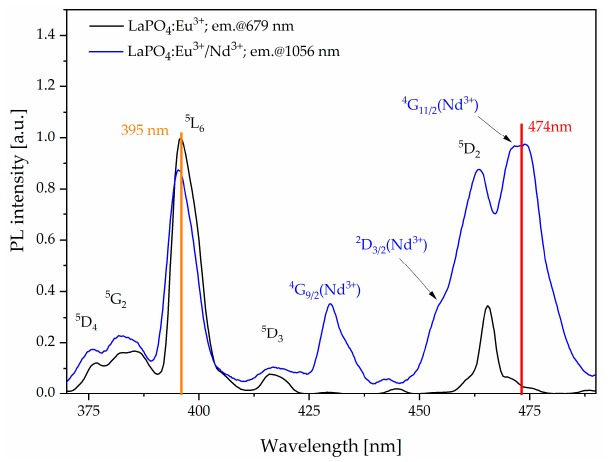
Figure 6. Photoluminescence (PL) spectra of LaPO 4 :Eu 3+ (black line) and LaPO 4 :Eu 3+ /Nd 3+ (blue line) nanophosphors.